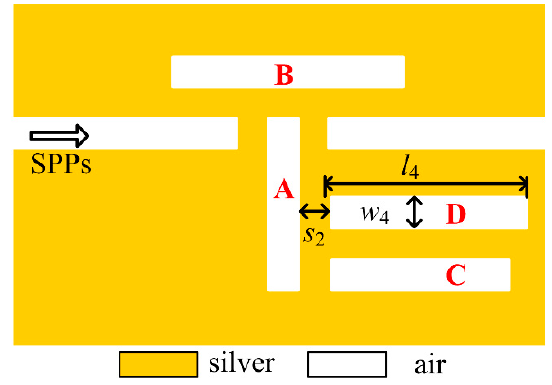
Figure 7. Schematic diagram of Fano resonant structure after adding cavity D . Figure 7. schematic diagram of Fano resonant structure after adding cavity D . Figure 7. schematic diagram of Fano resonant structure after adding cavity D .